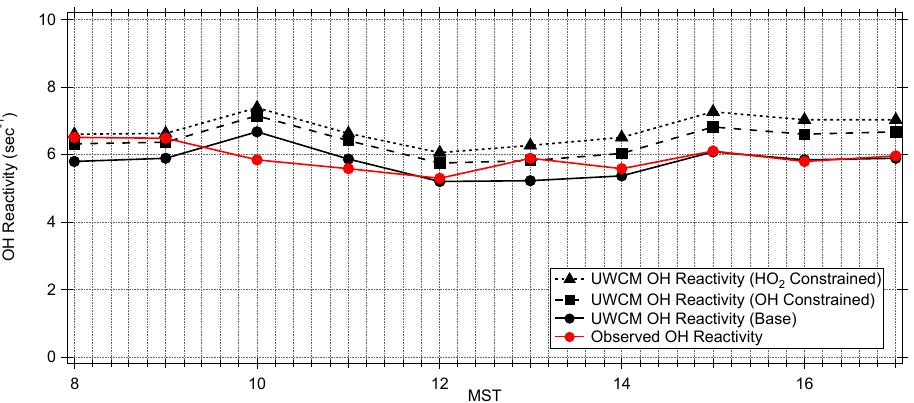
Fig. 7. The daytime variations of observed OH reactivity and UWCM calculated OH reactivity from the various model scenarios, described in the